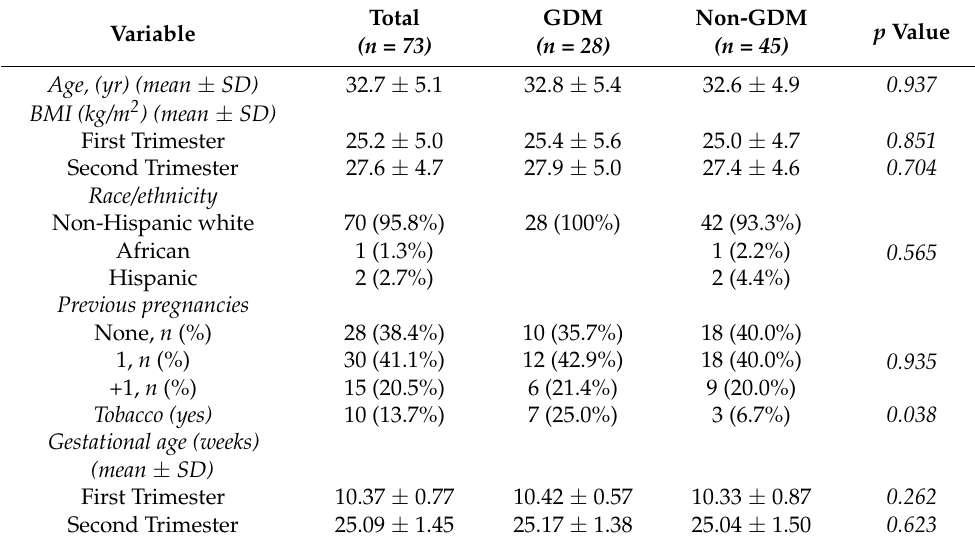
Table 1. Characteristics of the study participants presented as the total study population and stratified according to gestational diabetes mellitus (GDM)